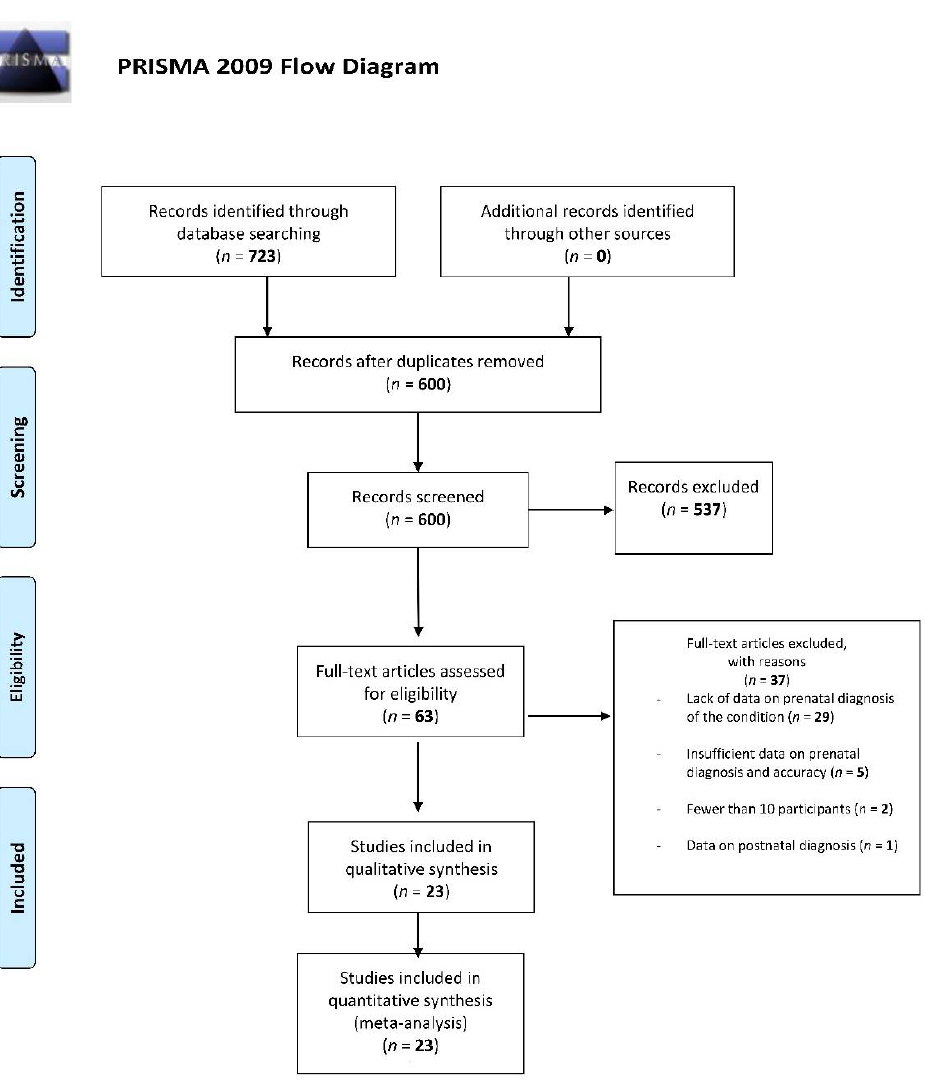
Figure 1. PRISMA flow diagram for studies selection.